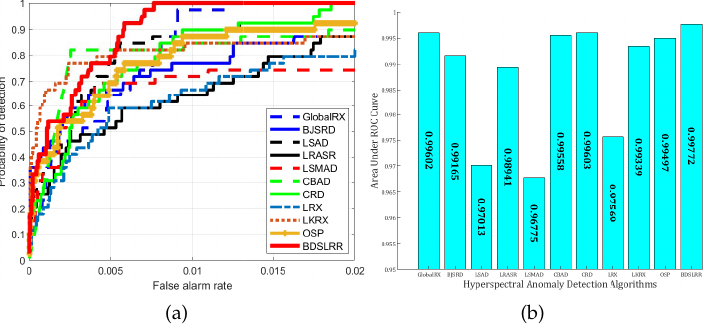
Figure 20. Detection accuracy evaluation for the Pavia dataset. ( a ) ROC curves; ( b ) AUC